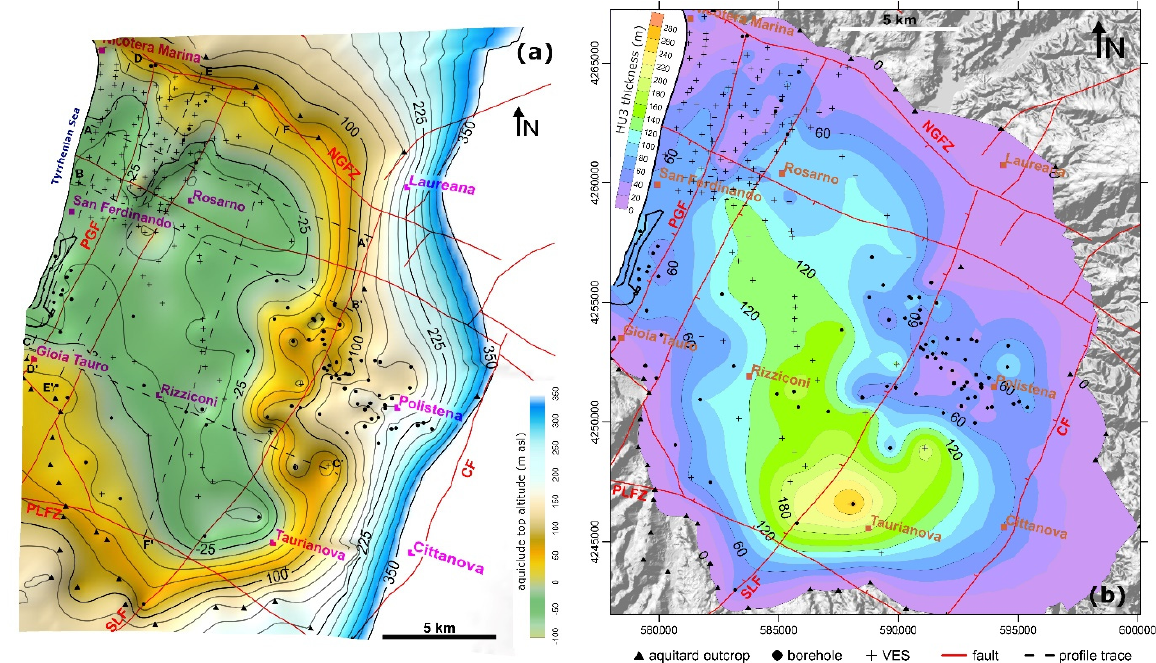
Figure 3. ( a ) Digital Surface Model of the aquiclude (HU2) top altitude (m a.s.l.). ( b ) Isopach map (m) of the shallow aquifer (HU3).